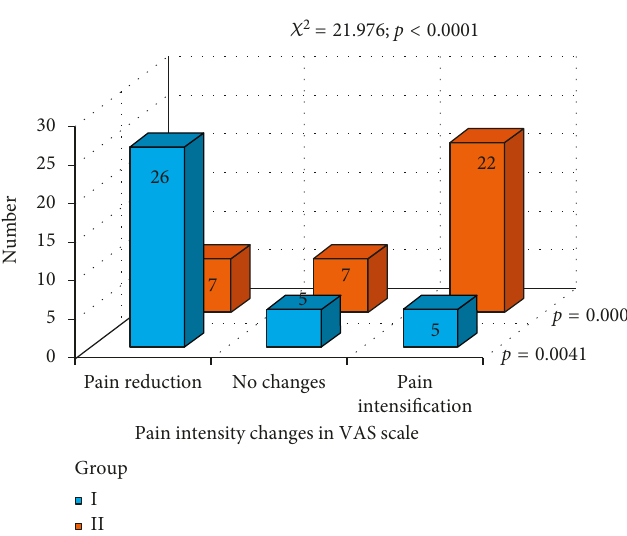
Figure 16: Pain intensity changes in both groups, as a result of the prosthodontic